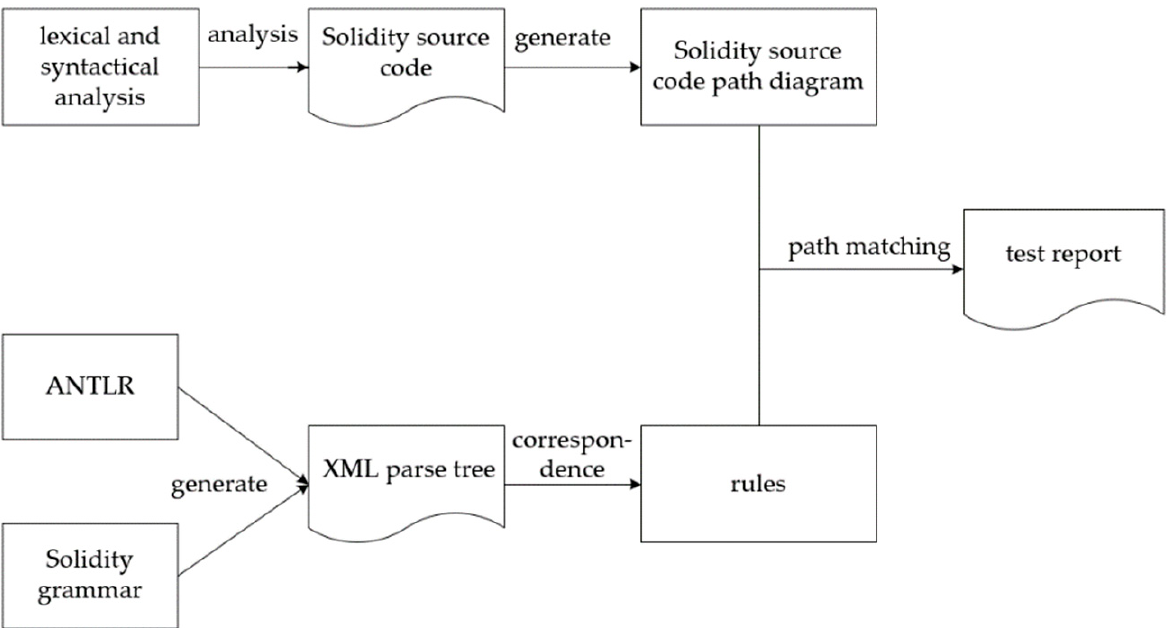
Figure 7. MSmart analysis flow chart.